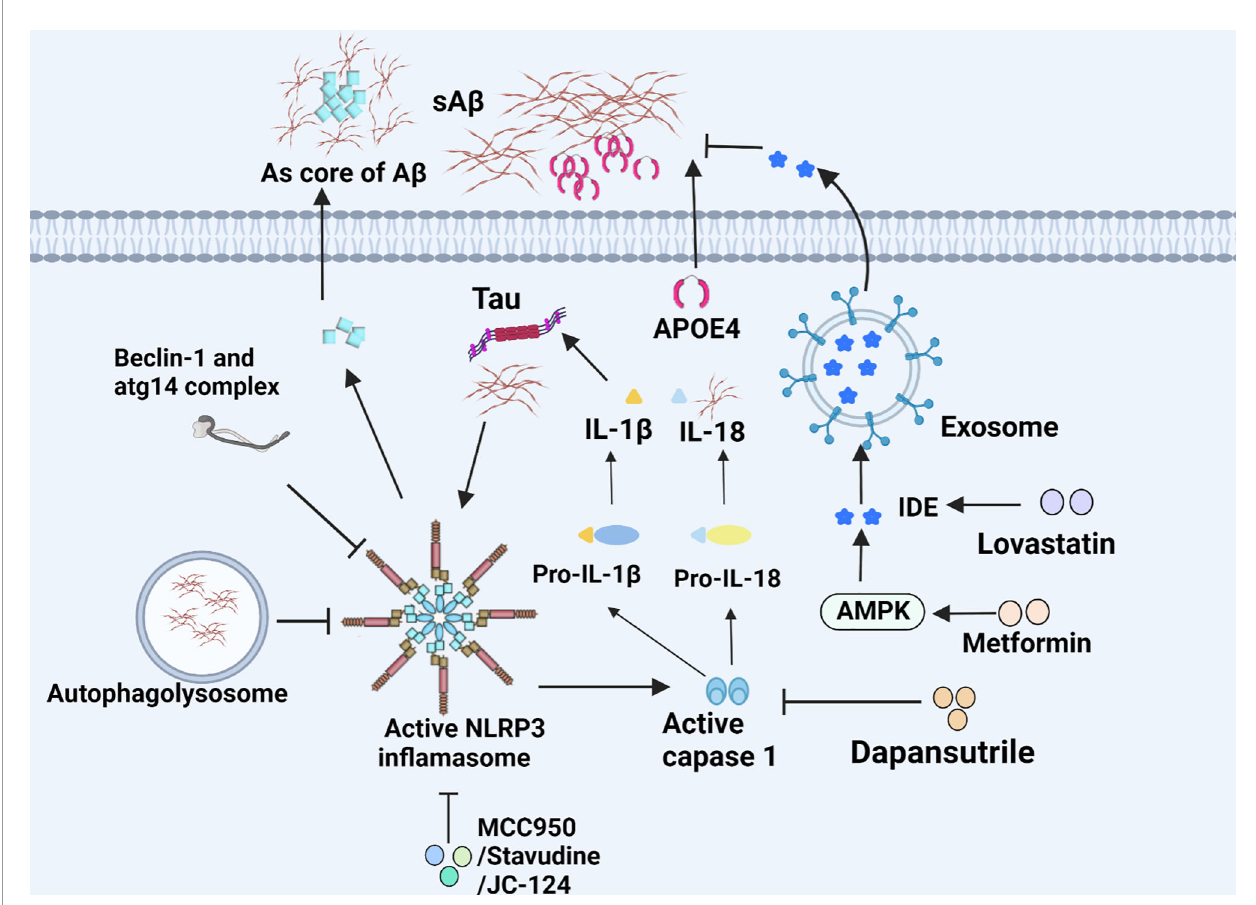
FIGURE 2 | NLRP3 in fl ammasome and IDE in microglia of AD. The NLRP3 in fl ammasome accelerates microglial in fl ammation and can be inhibited by various substances. The secretion of IDE helps degrade A b and is regulated by diverse